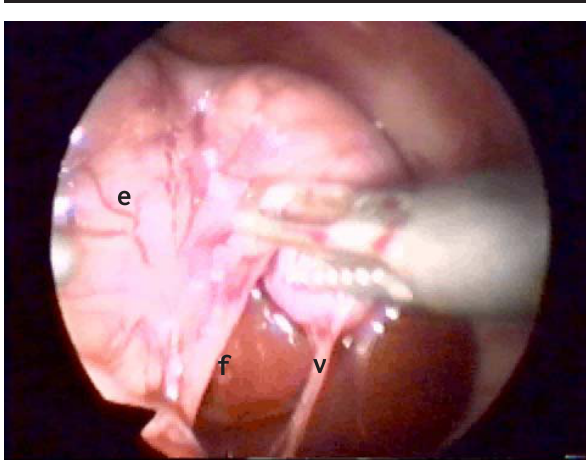
FIGURA 2 – Fotografia mostrando o estômago (e), os vasos gástricos curtos (v) e o fígado (f). Na versão on-line ao clicar sobre a figura pode-se assistir o procedimento de dissecção e colocação do clipe nos vasos gástricos esquerdos e nos vasos gástricos